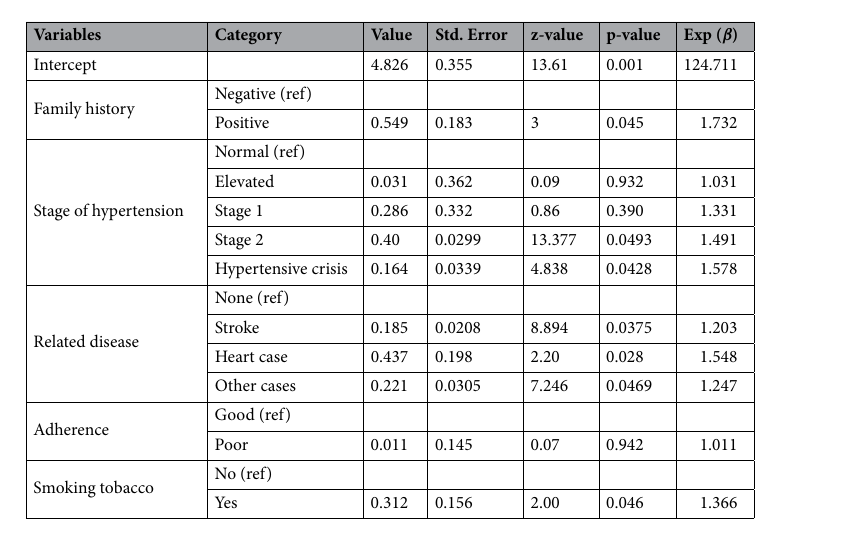
Table 4. Results of analysis of survival data using Weibull